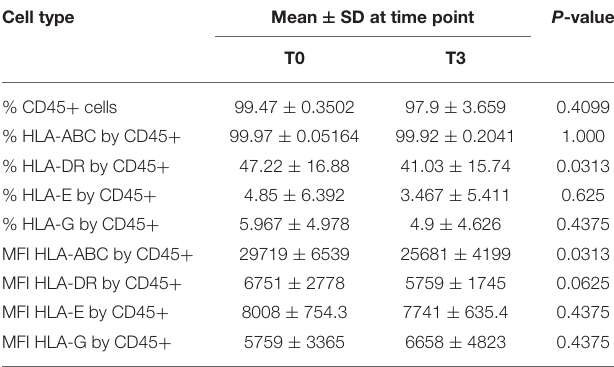
TABLE 4 | Effect of curcumin supplementation on total